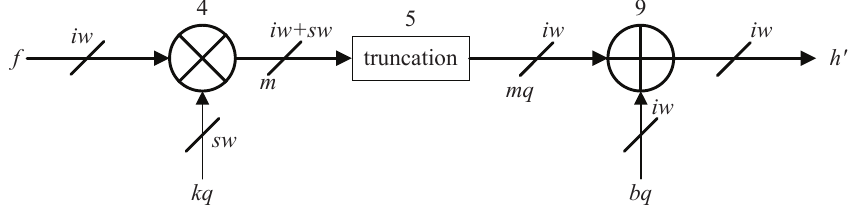
Figure 6. Computational flow of the proposed PWL method. The numbers under the computing units are the lines of the corresponding simulation code in Figure